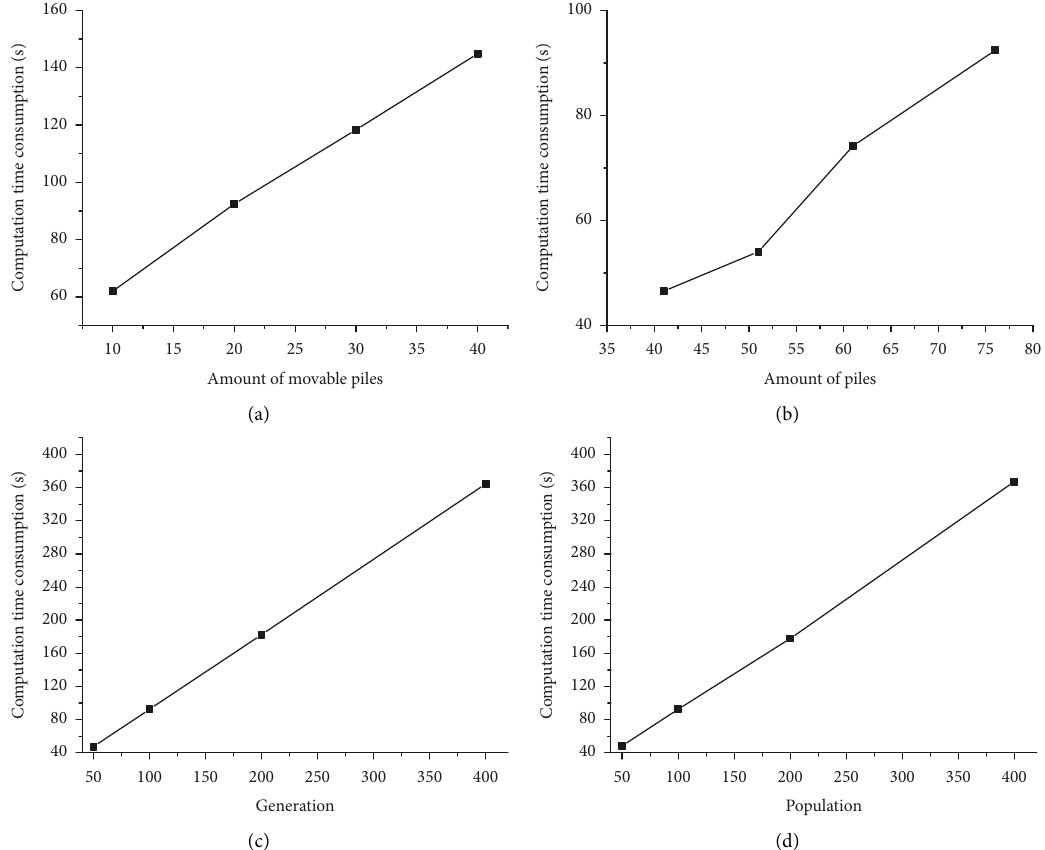
Figure 11: The computation time consumption is affected by parameters. (a) Amount of movable piles. (b) Amount of piles. (c) Gen- erations. (d)